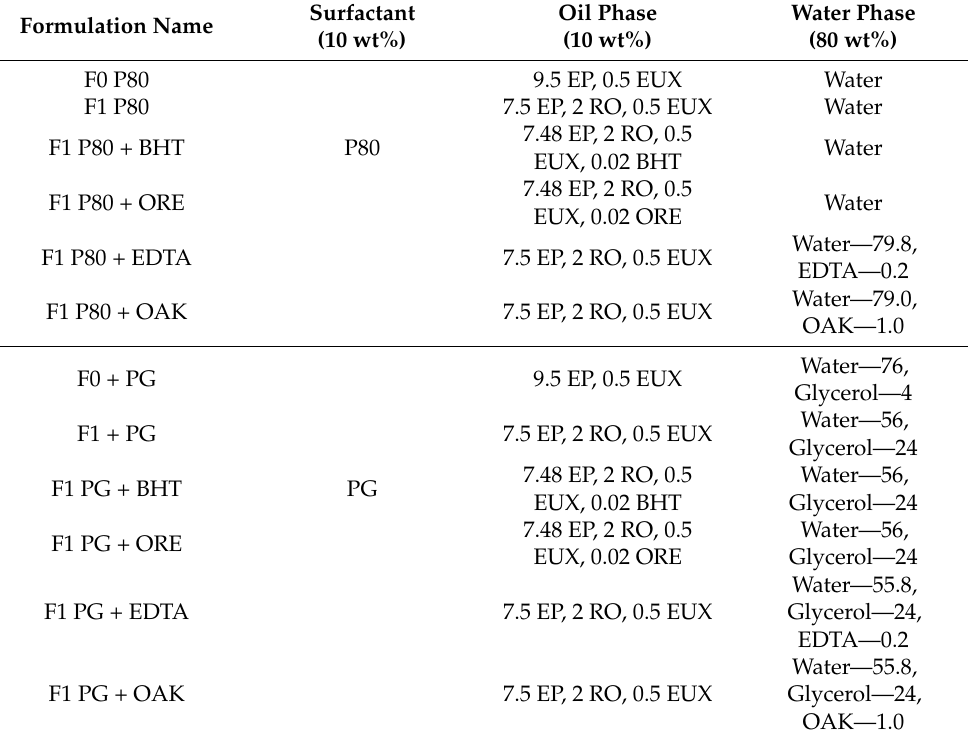
Table 1. Composition of nanoemulsions prepared with different